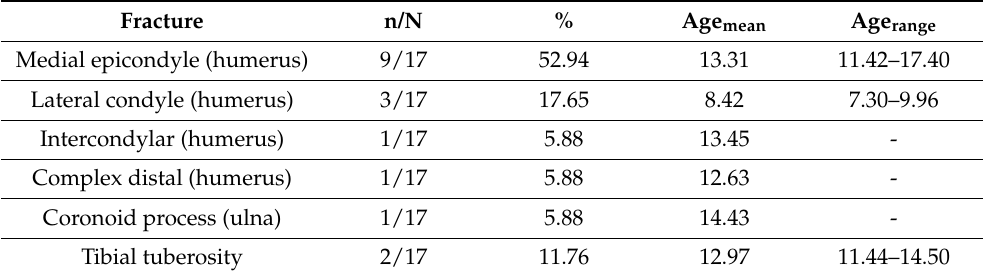
Table 2. Descriptive statistics for the six different fracture types in this study. Fracture n/N % Age mean Age